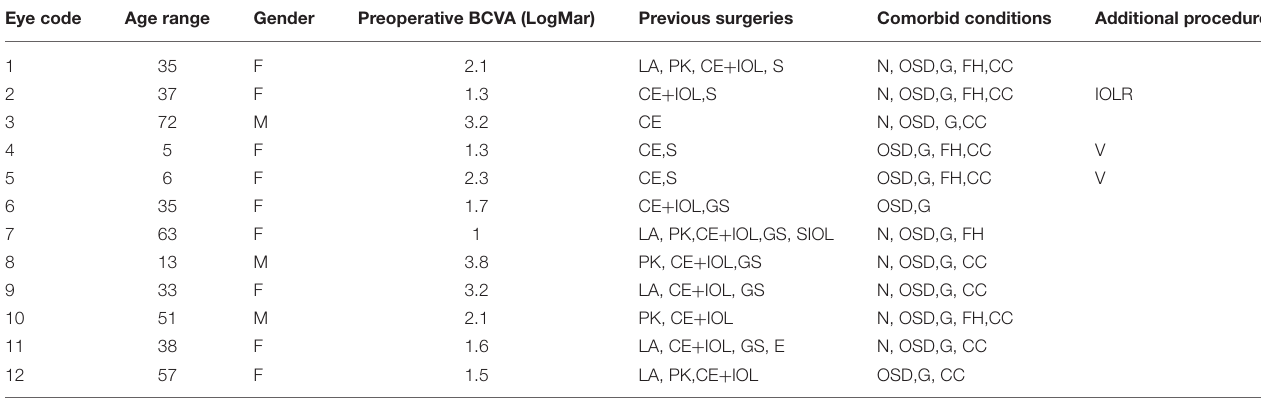
TABLE 1 | Demographics and clinical preoperative features in each case. Eye code